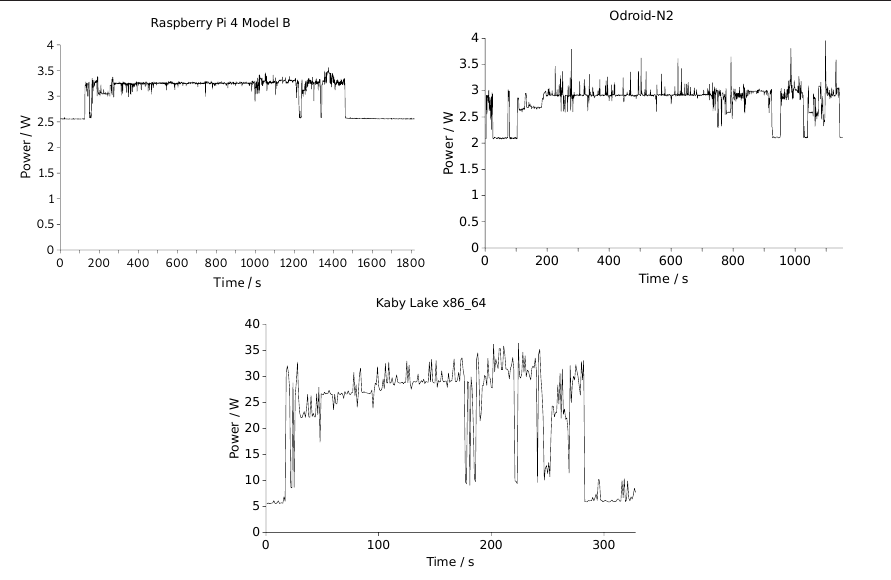
Figure 2. The RPi4 power during a CMSSW job averaged 3.23 W and that of the Odroid-N2 2.82 W and on a Kaby Lake 27.14 W.